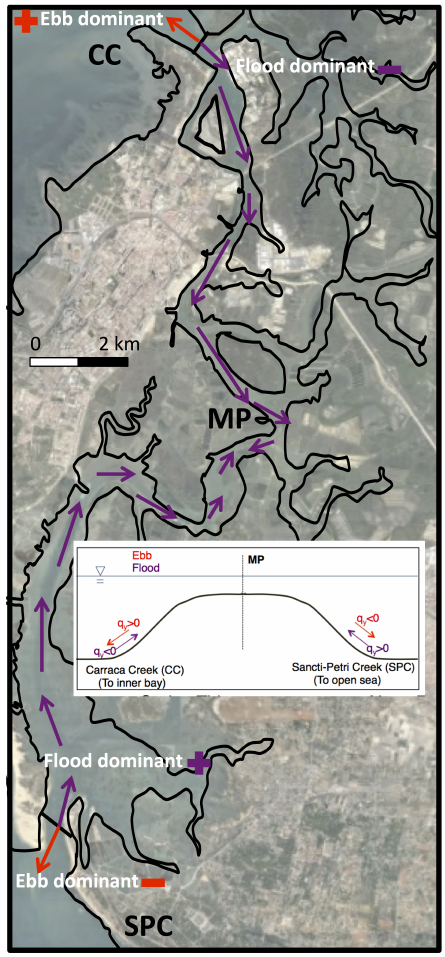
Figure 13. Criteria of sign in Cádiz creeks. Considering positive (negative) if the flow direction is from the ocean to the basin (from the basin to the